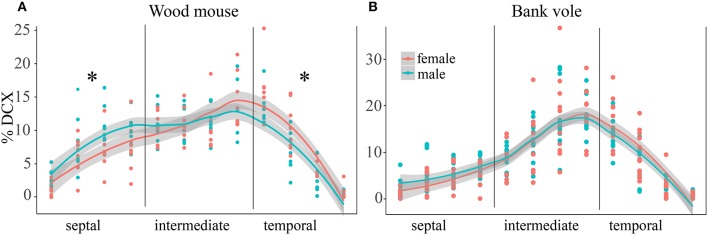
Sex differences in DCX+ cells in wood mice along the hippocampal axis. The septal < temporal gradient in DCX+ cell distribution is more pronounced in female wood mice (A) as compared to males. Septally, they have lower values than males, while temporally females DCX+ values exceed those of males. In bank voles (B), males and females do not differ with regard to DCX+ cell distribution along the septo-temporal axis. *p < 0.05; for exact values see results.